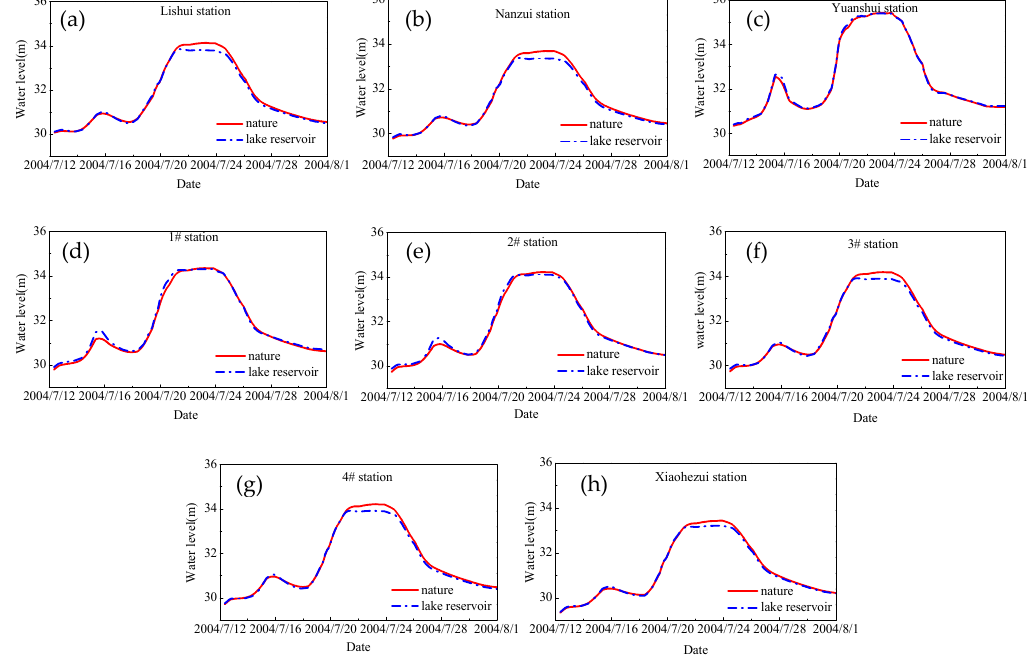
Figure 7. The time series of water elevations recorded at eight selected stations.